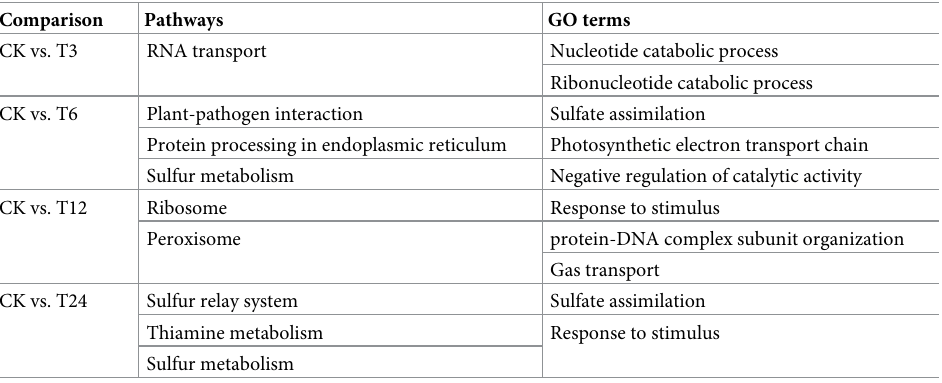
Table 2. KEGG and GO enrichment analysis results on all